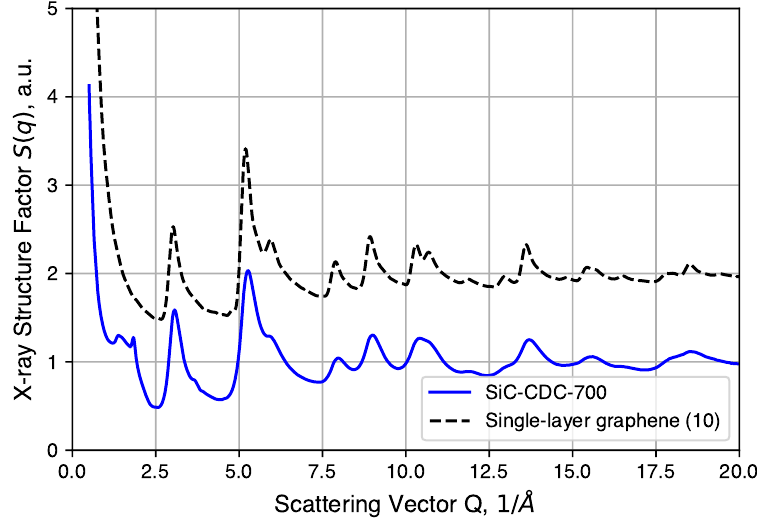
Figure 7. Comparison between experimental structure factor of CDC and simulated data of single graphene layer (10 × 10 unit